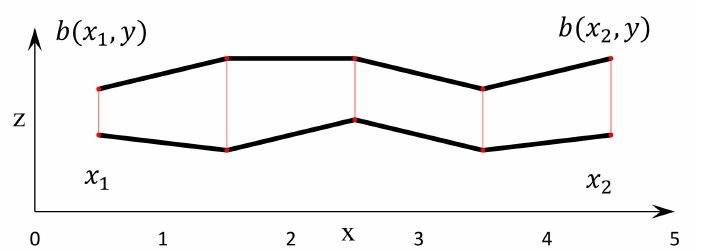
Figure 5. Illustration of a series of two-dimensional connected local wedges along the longitude direction x ; a similar set of connected wedges can also be formed along the latitude direction y (after